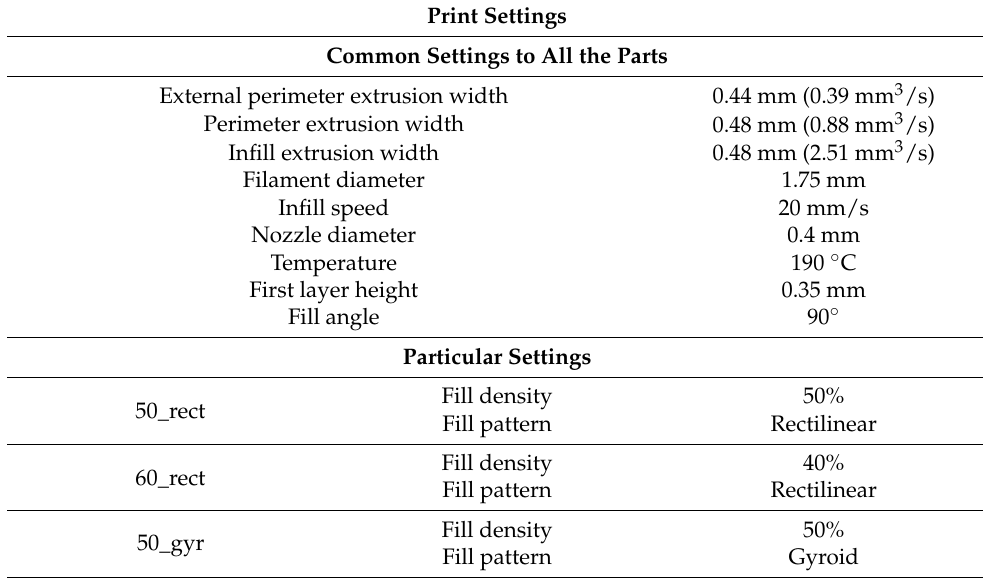
Table 2. Printing Parameters of